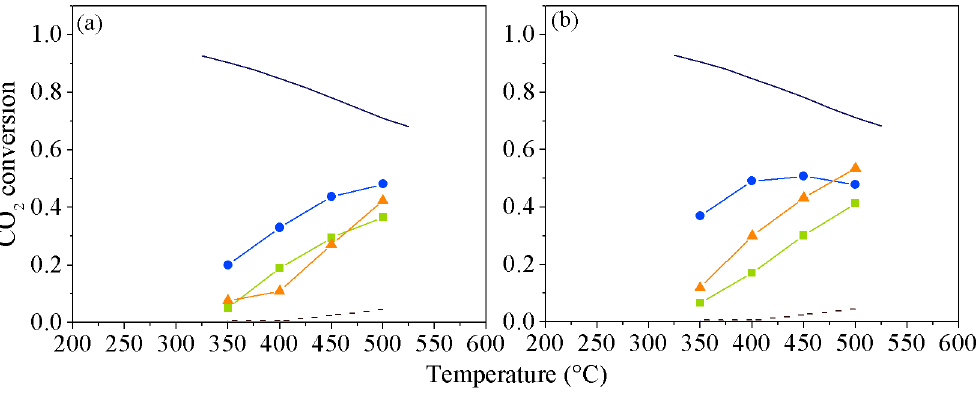
Figure 2. Carbon dioxide conversion on nickel-supported catalysts. ( a ) 10 wt %, ( b ) 20 wt %. ( ) ZrO 2-COP , ( ▲ ) SiO 2 , ( ) MgAl 2 O 4 , (dashed line) SiC, (solid line) equilibrium conversion.